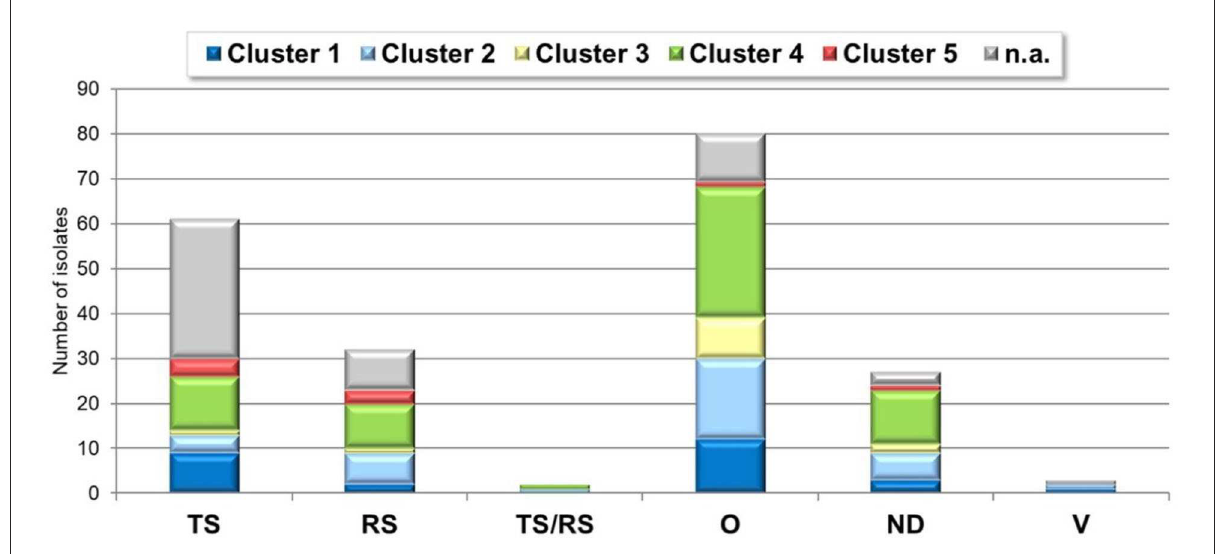
FIGURE7 ARV cluster-clinical condition distribution. TS, tenosynovitis/arthritis; RS, runting-stunting syndrome; O, other; ND, not defined; V,